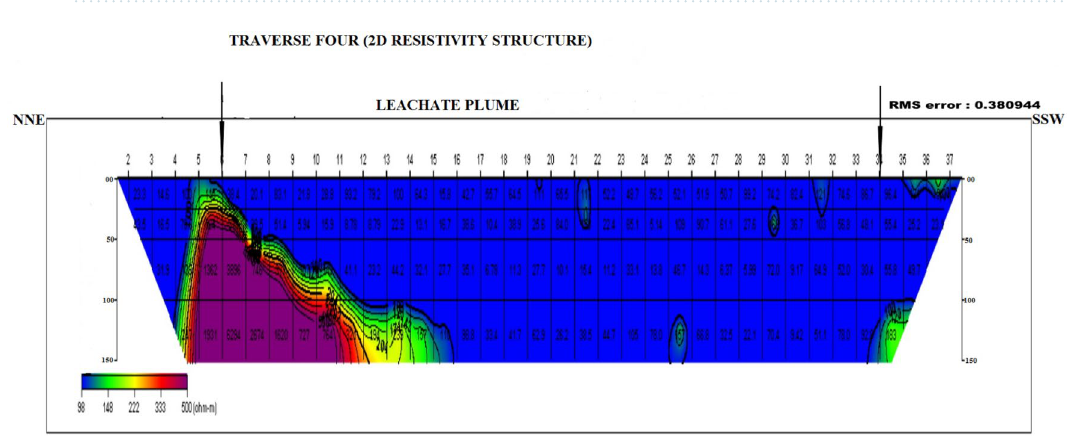
Figure 12. 2D Resistivity Structure of Traverse